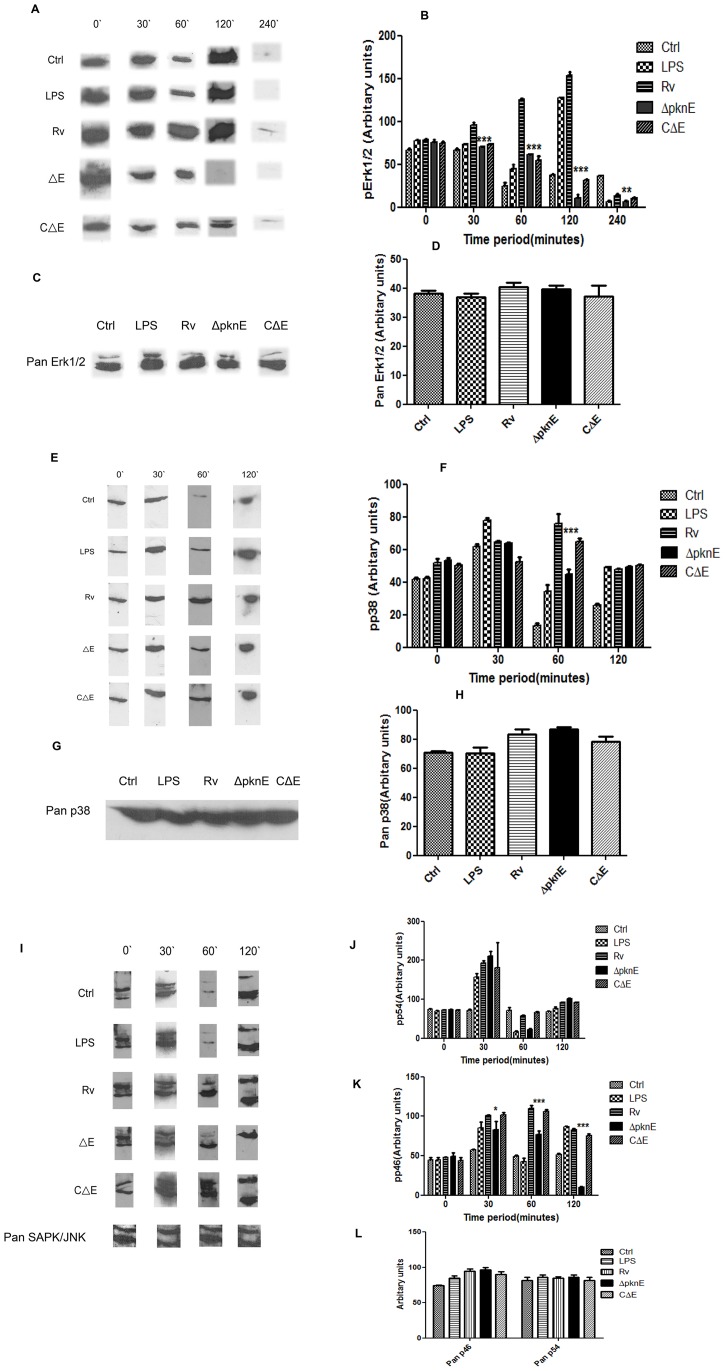
ΔpknE infected macrophages are defective in MAPK signaling.Controls (Ctrl, LPS) and infected cells were lysed post infection at varied time points and subjected to western blotting. The blots were probed with phospho A) Erk1/2, E) p38, and I) SAPK/JNK and their respective non phospho (C, G and I) antibodies. The results are from three independent experiments. Figures B, D, F, H, J, K, and L depict the corresponding densitometry values of phospho and nonphospho antibody probed blots. *, *** denotes p<0.05 and p<0.0001, when ΔpknE infected macrophages compared with Rv (one – way ANOVA). The abbreviations ctrl denotes control and LPS denotes lipopolysaccharide.